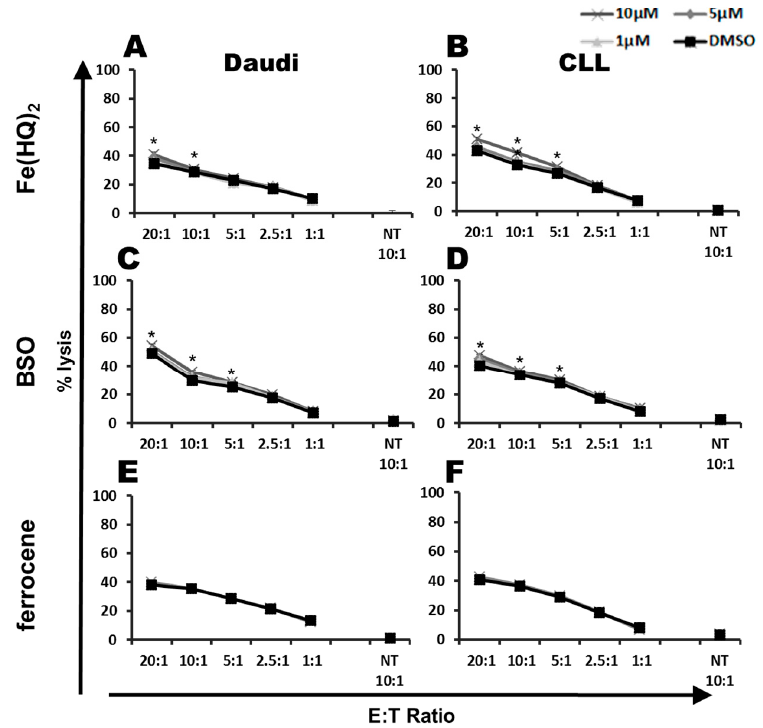
Figure 4. Influence of unspecific ROS accelerators and ferrocene on the cytotoxic capacity of CARTs. Cytotoxicity of CD19-specific CARTs was determined by 51 Cr release assay after co-culture with the CD19 + Burkitt lymphoma cell line Daudi ( A , C , E ), as well as CD19 + primary CLL cells ( B , D , F ). Co-incubation with CARTs in di ff erent E:T ratios (20:1, 10:1, 5:1, 2.5:1, 1:1) and non-transduced T